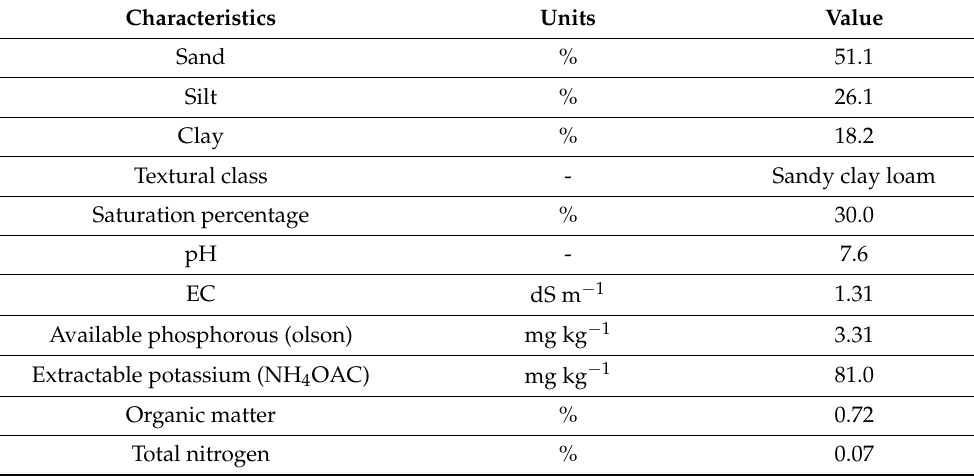
Table 2. Physical and chemical characteristics of soil used in the